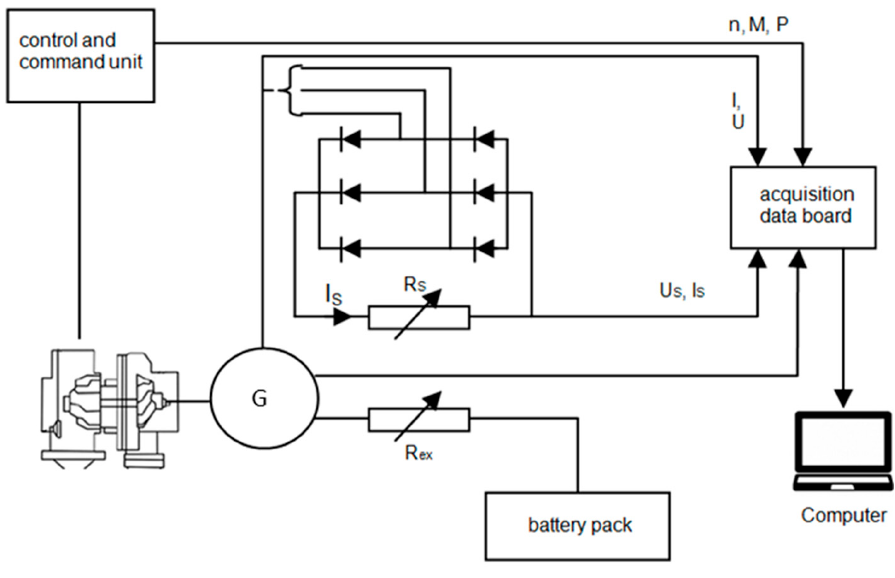
Figure 8. Diagram of the exhaust system [46]. Table 2 indicates the resulting parameters, namely the evaluated parameter, the unit of measurement, and the value of the parameter. Table 2. The resulting parameters .